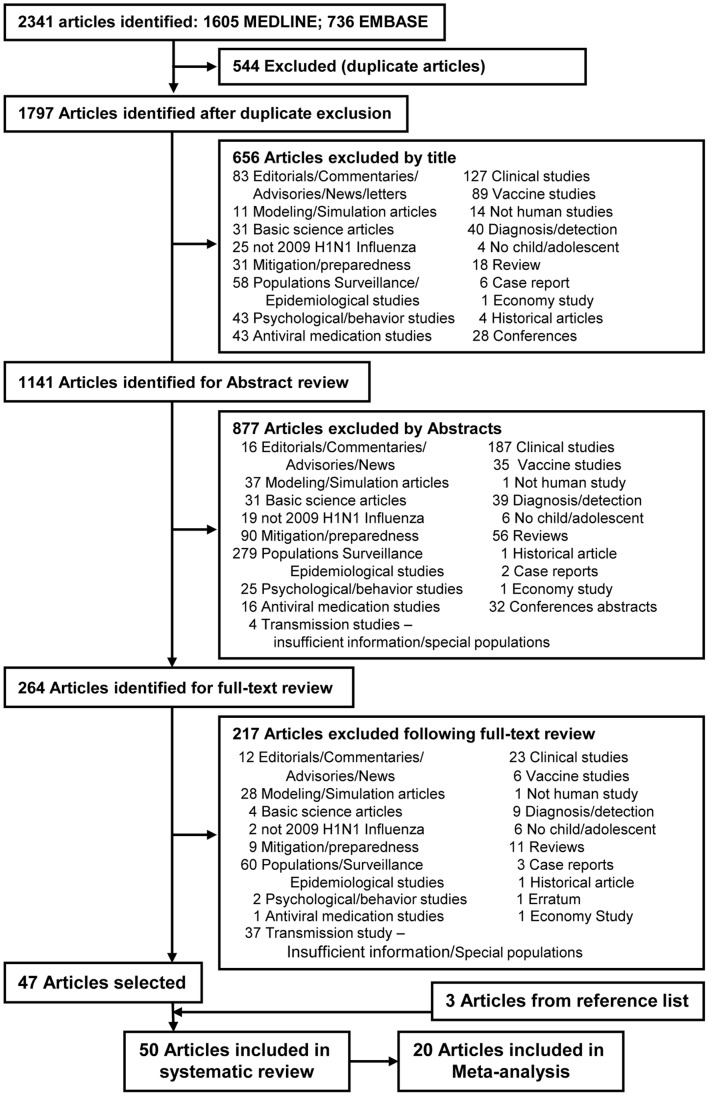
Flow chart for study selection.